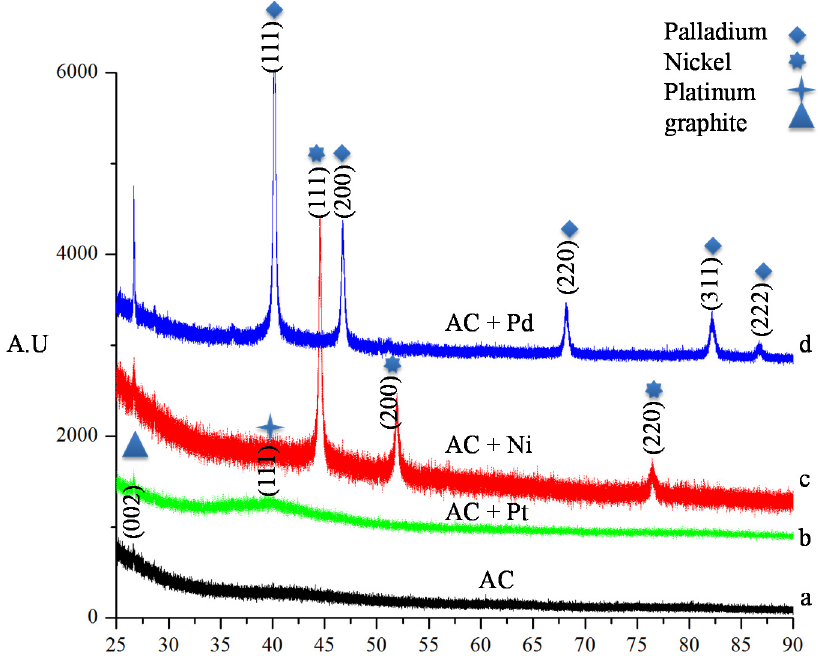
Figure 1. XRD diffraction patterns of ( a ) activated carbon (AC), ( b ) Pt-anchored AC, ( c ) Ni-anchored AC and ( d ) Pd-anchored